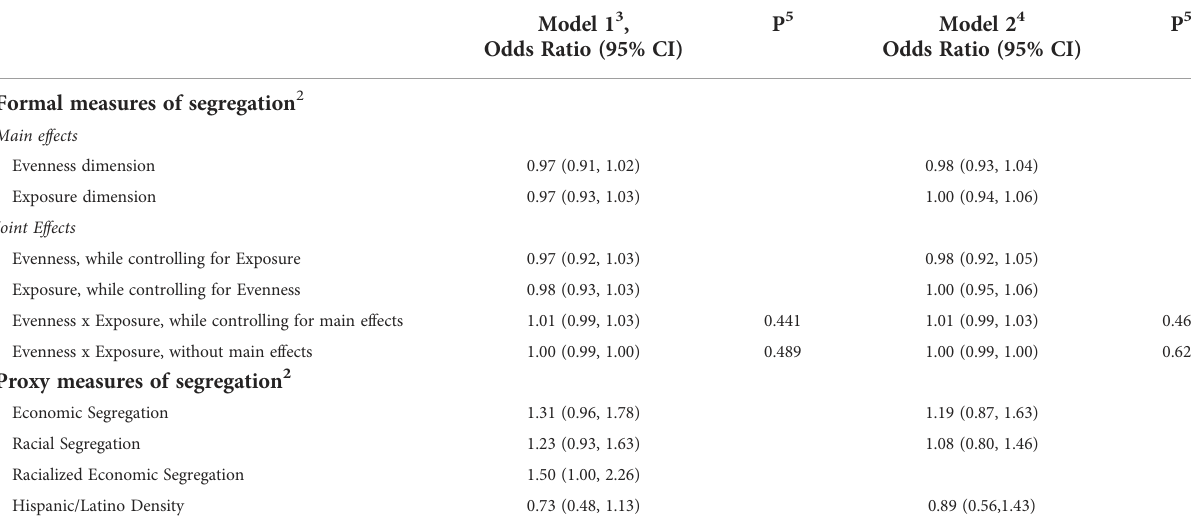
TABLE 8 Ordered logistic regression models for the association between neighborhood segregation measures and adherence to the individual components of the ACS 1 guidelines on nutrition and physical activity for cancer prevention, N = 11,